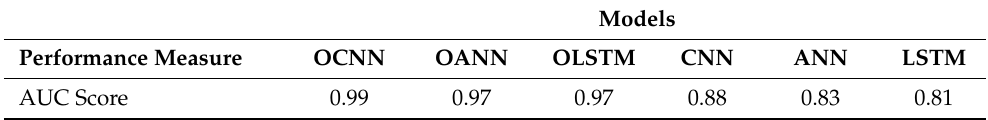
Table 4. Experimental result of AUC score among the models.